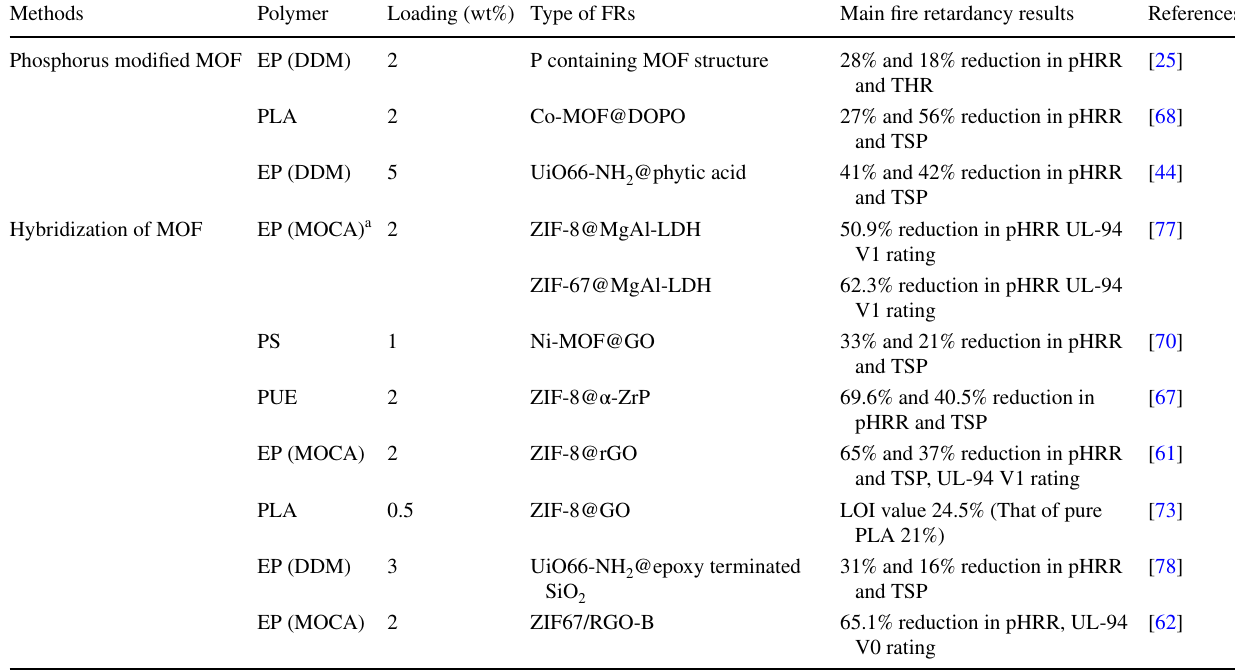
Table 2 Summary of MOF hybrids as FRs on fire retardancy of polymer composites